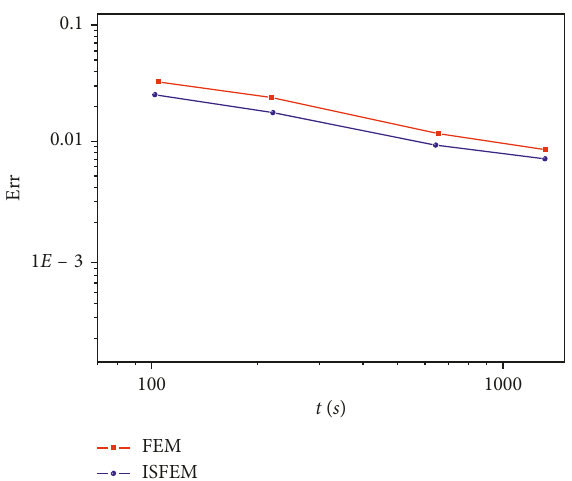
Figure 8: Comparison of computational Table 2: Displacement u 3 and electrical potential φ at the loading point with the gradient parameter n based on PZT-4.